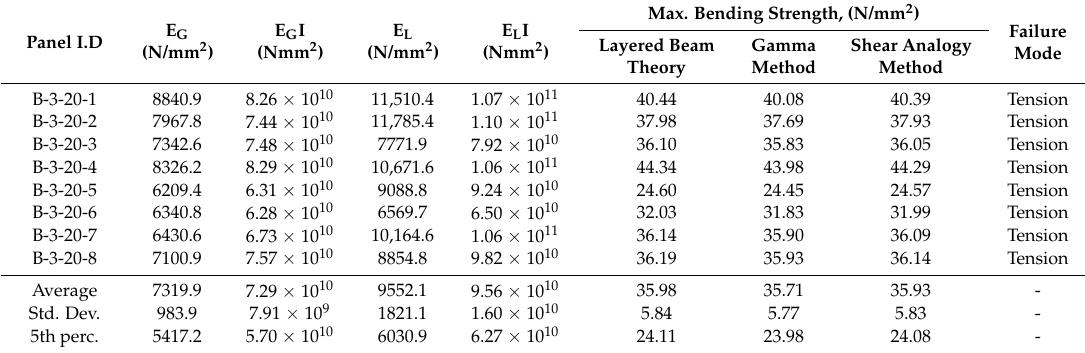
Table 2. Bending test results for three-layer B-3-20 configuration. E G —global elastic moduli; E G I—global elastic moduli; E L —local stiffness; E L I—global stiffness.